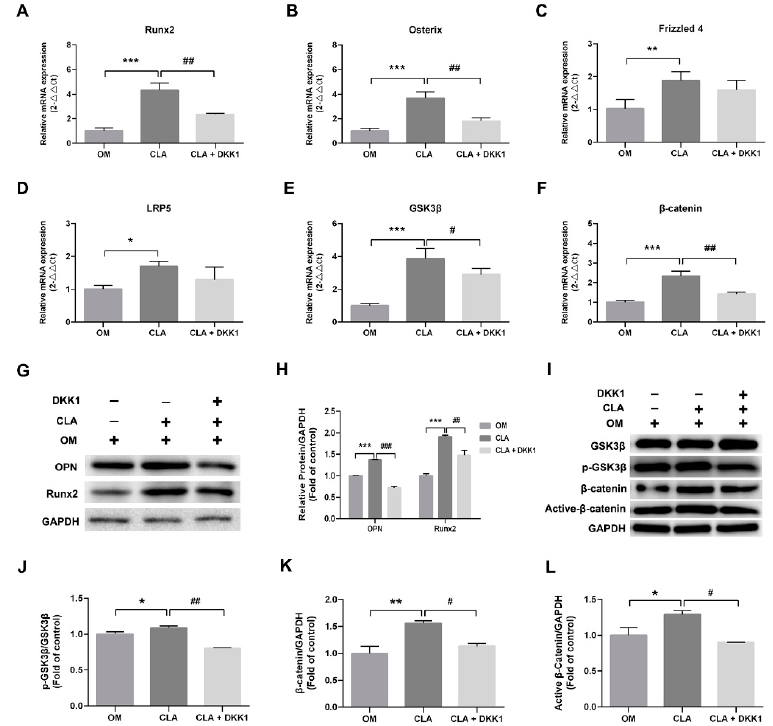
Figure 7. Effects of DKK1 on CLA-stimulated gene expression and protein expression in hBMSCs. Cells were induced for osteoblast differentiation for 7 d (OM), with 1 µ M CLA alone (CLA), or with 1 µ M CLA and 0.5 µ g/mL DKK1 (CLA + DKK1). ( A – F ) RT-qPCR analysis for mRNA expression of Runx2 ( A ), Osterix ( B ), Frizzled 4 ( C ), LRP5 ( D ), GSK3 β ( E ), and β -catenin ( F ). ( G ) Western blot analysis for protein expression of Runx2 and OPN, and ( H ) protein expression of Runx2 and OPN normalized to GAPDH; ( I ) Western blot analysis for protein expression of GSK3 β , p-GSK3 β (Ser9), β -catenin and active- β -catenin; ( J – L ) quantified protein expression normalized to GAPDH. Data are expressed as mean ± SD ( n = 3). Compared to OM, data were significantly different at * p < 0.05, ** p < 0.01, *** p < 0.001; compared to CLA, data were significantly different at # p < 0.05, ## p < 0.01, ### p <